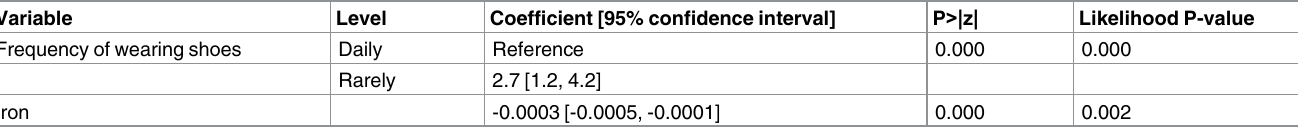
Table 8. Parsimonious multivariable ( P (cid:20) 0.05) model for the log of expected counts of Podoconiosis.